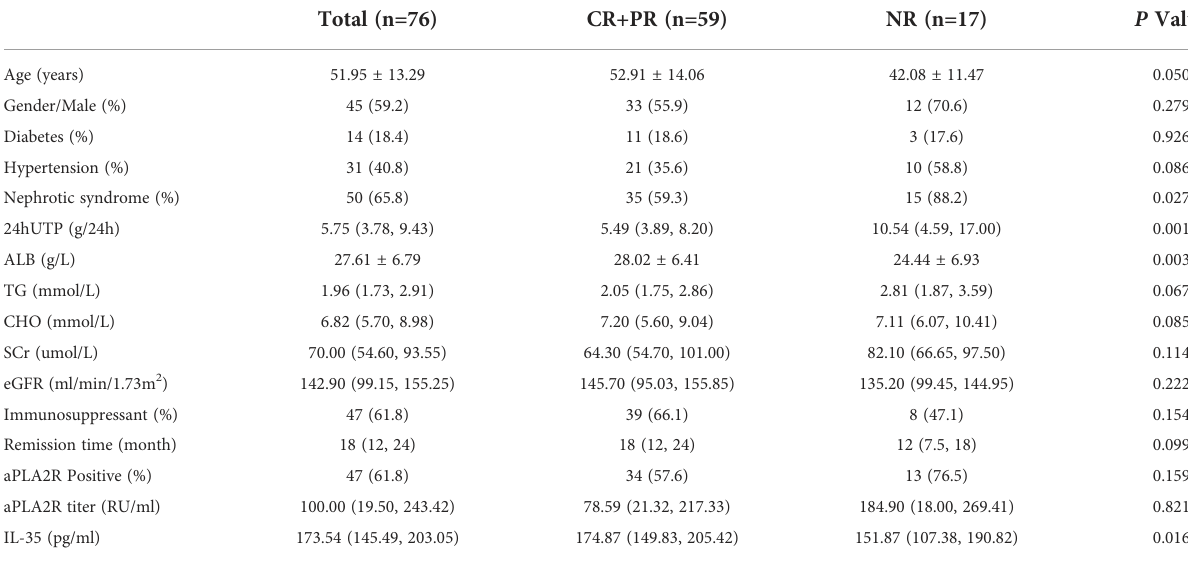
TABLE 1 Baseline characteristics of IMN patients according to disease